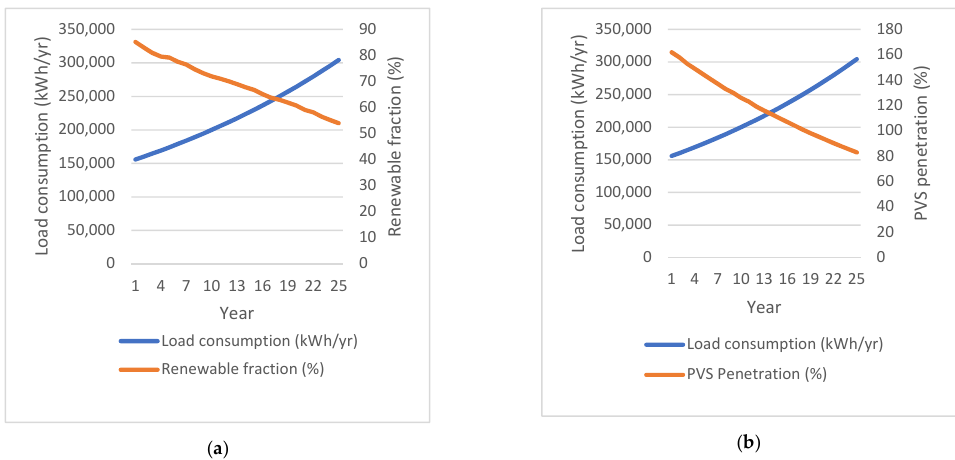
Figure 17. HOMER multi-year model ( a ) variation of load consumption with renewable fraction; ( b ) variation of load consumption with PVS penetration.